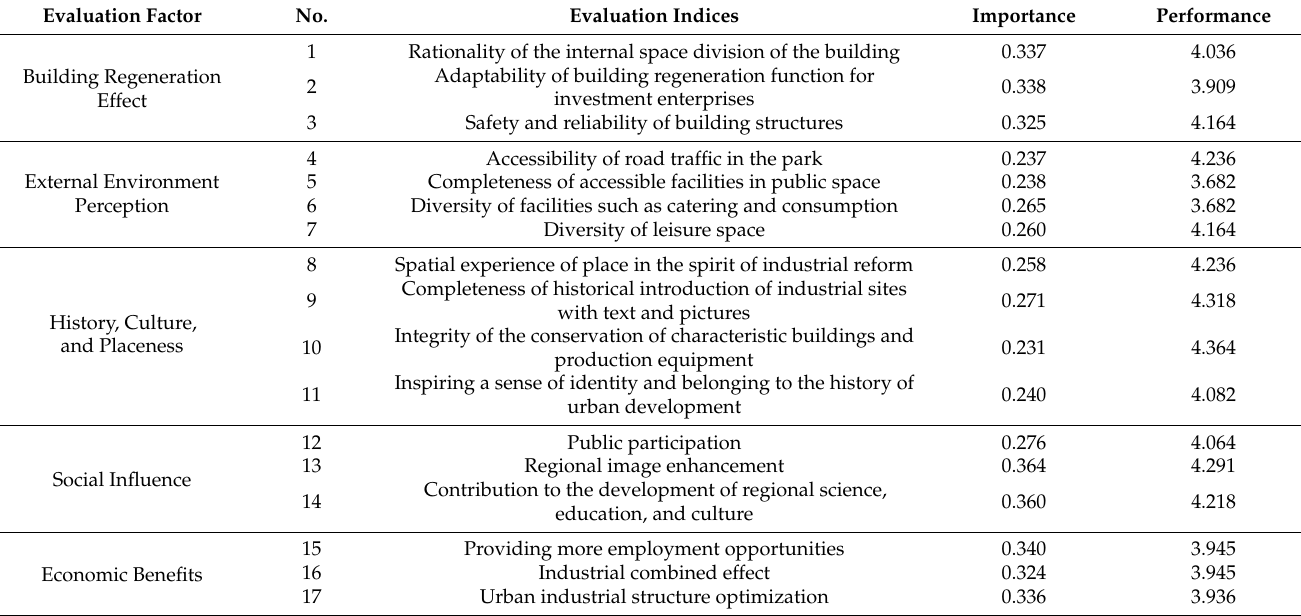
Table 6. Importance and performance of each evaluation